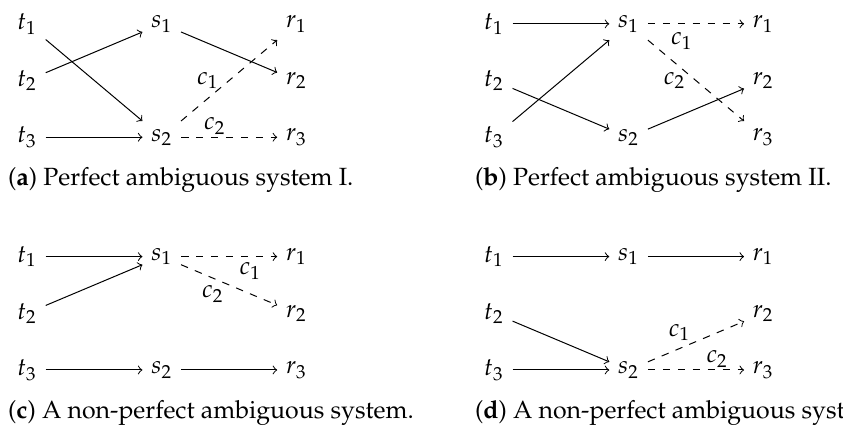
Figure 3. The two perfect ambiguous systems of the CB game are shown in ( a , b ), both of which achieve an expected utility of 1. Two (of 12) exemplary non-perfect but evolutionarily stable pooling systems of the CB game are shown in ( c , d ), both of which achieve an expected utility of 5